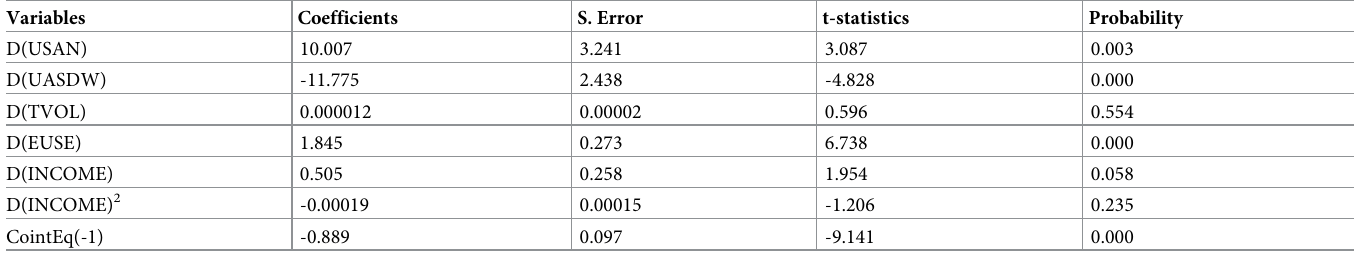
Table 6. ARDL short-run estimates.